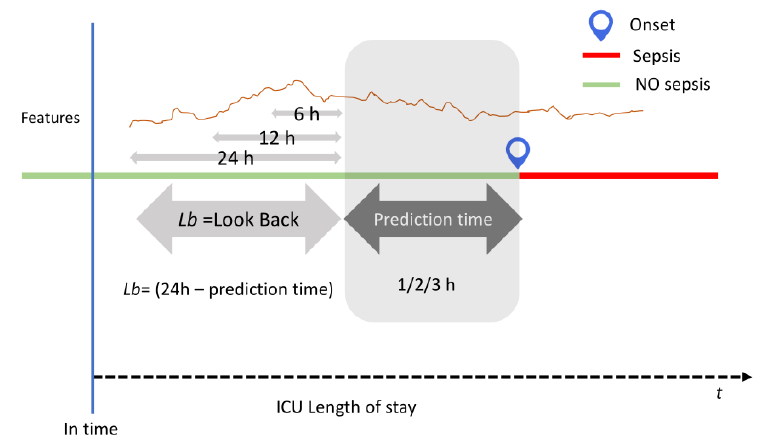
Figure 7. Prediction